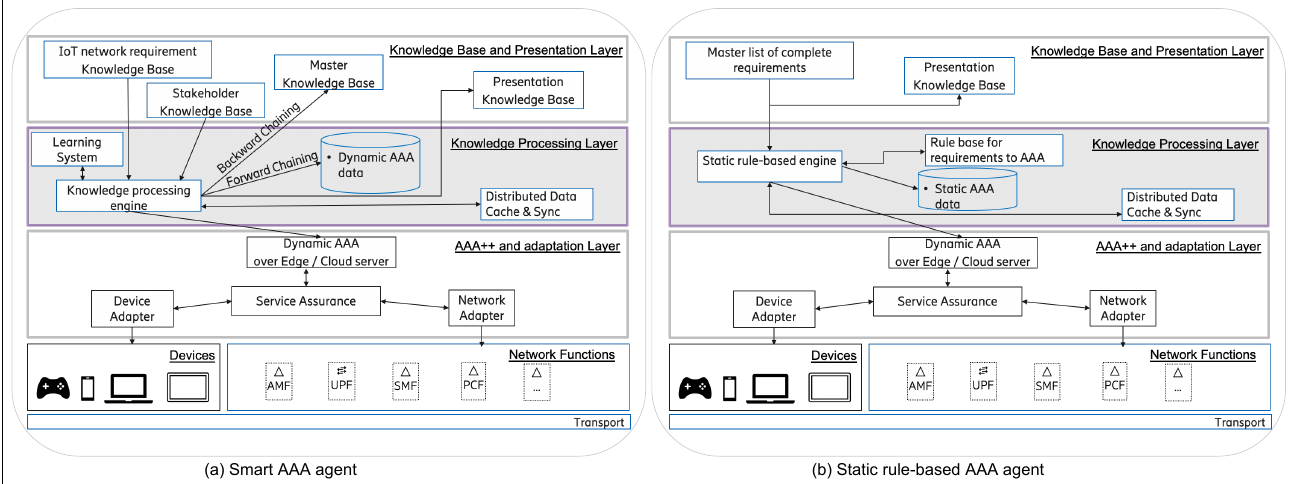
Figure 3. Proposed AAA agent candidate system and